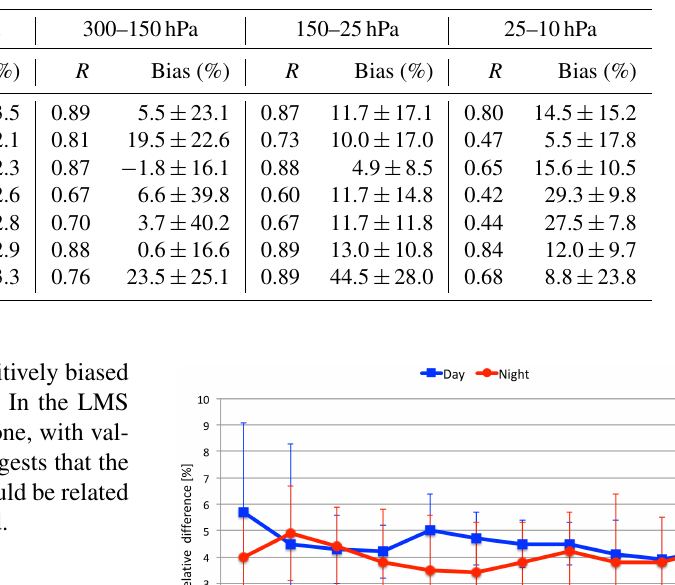
Table 5. Overview of the correlation ( R ), mean relative bias, and associated standard deviation (in percent) between IASI and sonde O 3 for the period 2008–2014 for different latitude bands and partial columns.